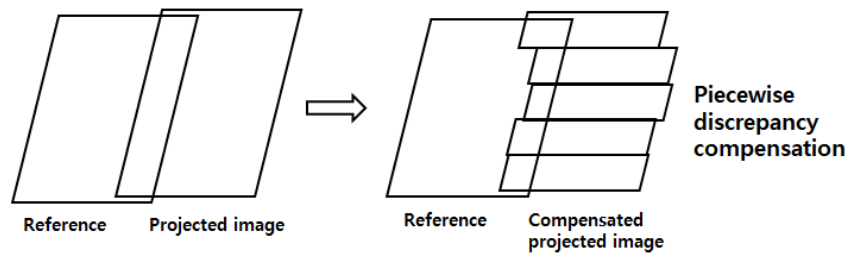
Figure 4. Piecewise discrepancy compensation.